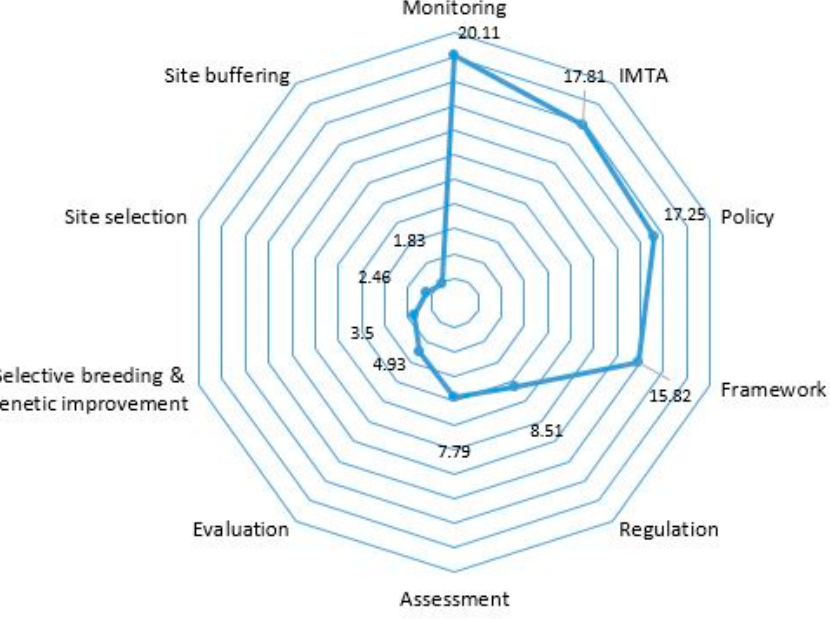
Figure 2. Radar chart that illustrates the existing knowledge gaps in relation to the main thematic areas for mitigating the effects of OA on seaweed aquaculture.